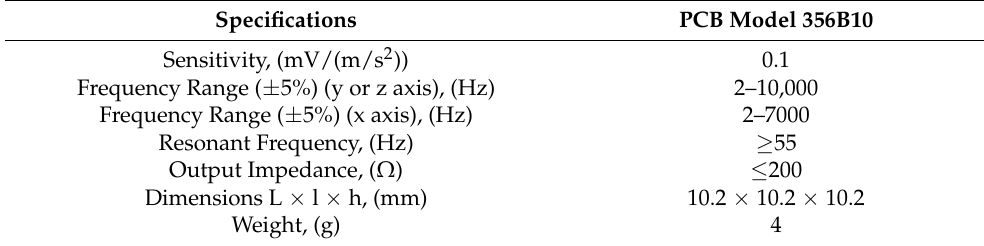
Table 1. Specifications of the PCB triaxial accelerometer model 356B10